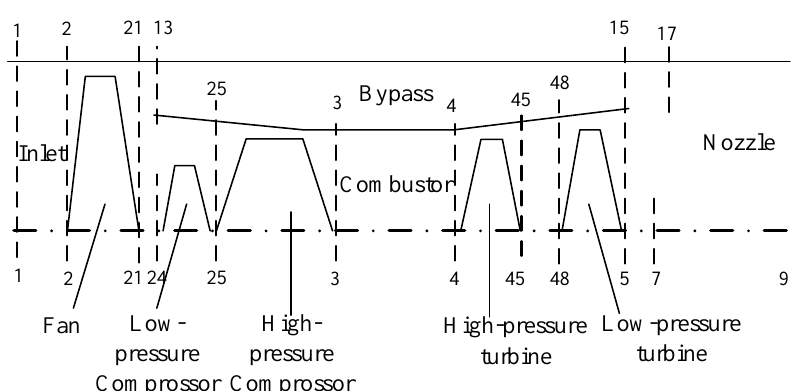
Figure 14. JT9D engine model diagram.